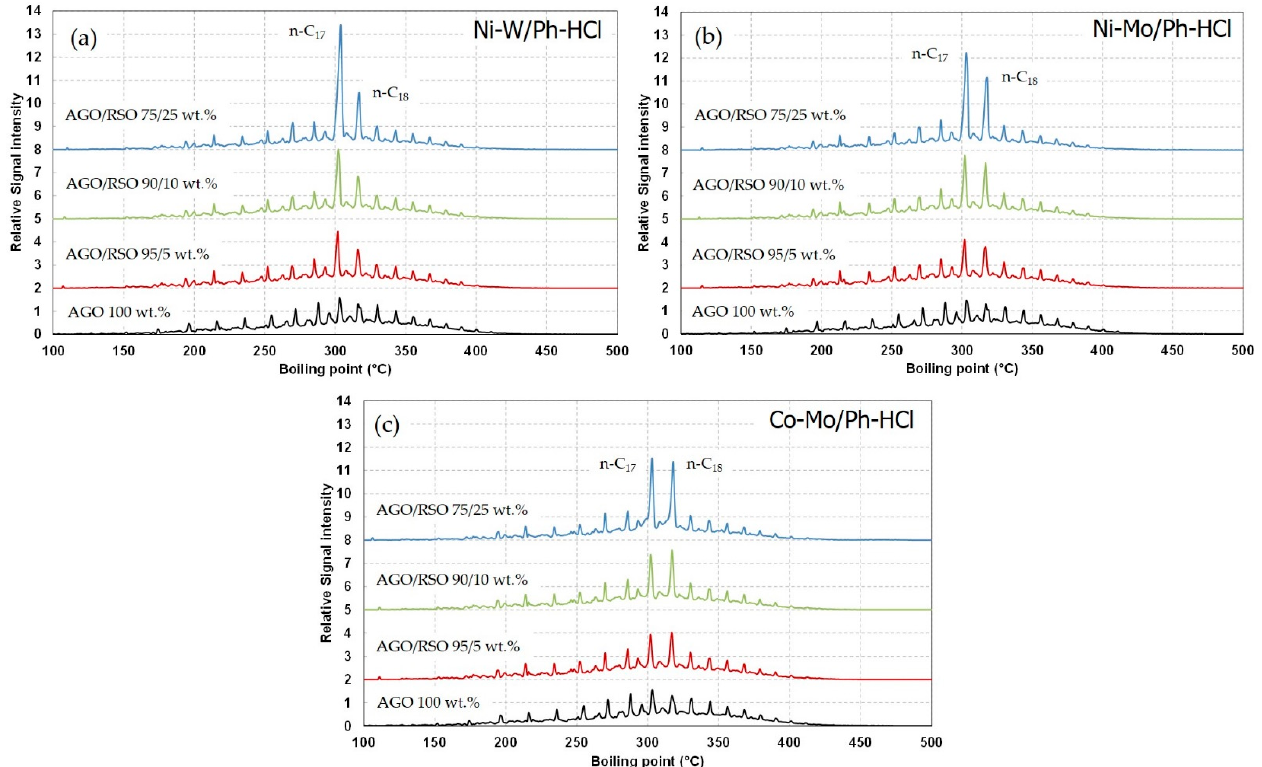
Figure 5. Simdis results of hydrotreated gas oil obtained during AGO processing (350 °C, WHSV 2 h − 1 , 5.5 MPa) and AGO/RSO co-processing (350 °C, WHSV 2 h − 1 , 5.5 MPa) at different ratios (95/5, 90/10 and 75/25) with Ph-HCl-supported catalysts (( a ): Ni-W/Ph-HCl; ( b ): Ni-Mo/Ph-HCl, ( c ): Co-Mo/Ph-HCl).